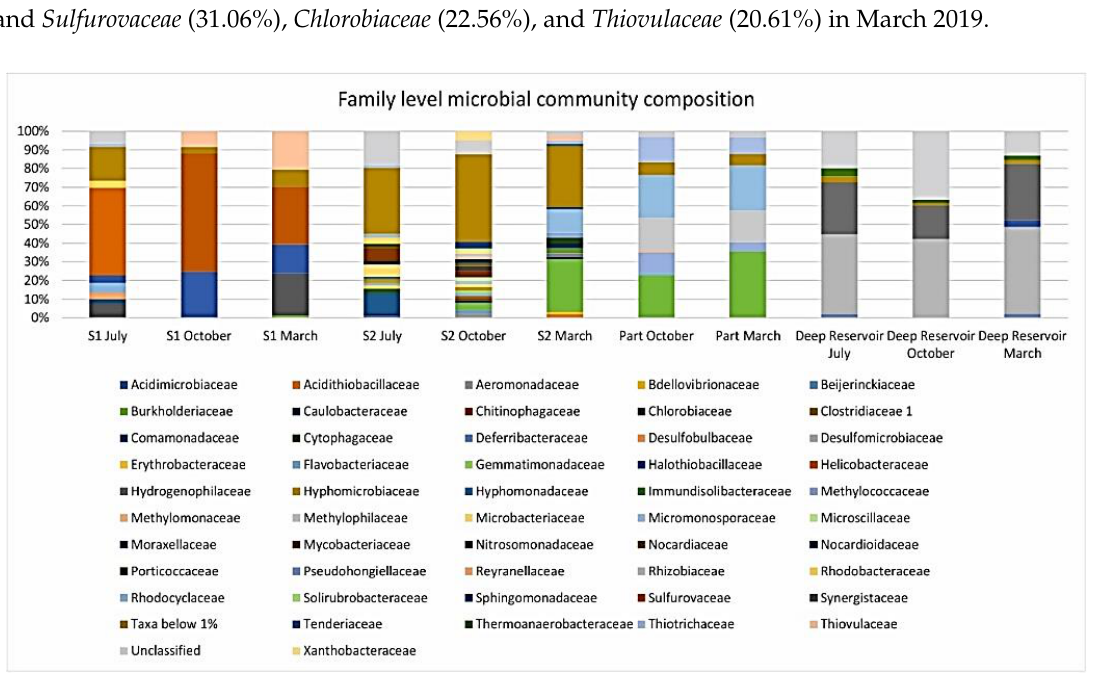
Figure 6. Family level microbial community composition in samples collected from springs, the P art well, and the deep reservoir. Table 3. Main bacterial genera identified in the P art , S1, and S2 samples. Growth temperatures of some of the species belonging to the different genera are reported.